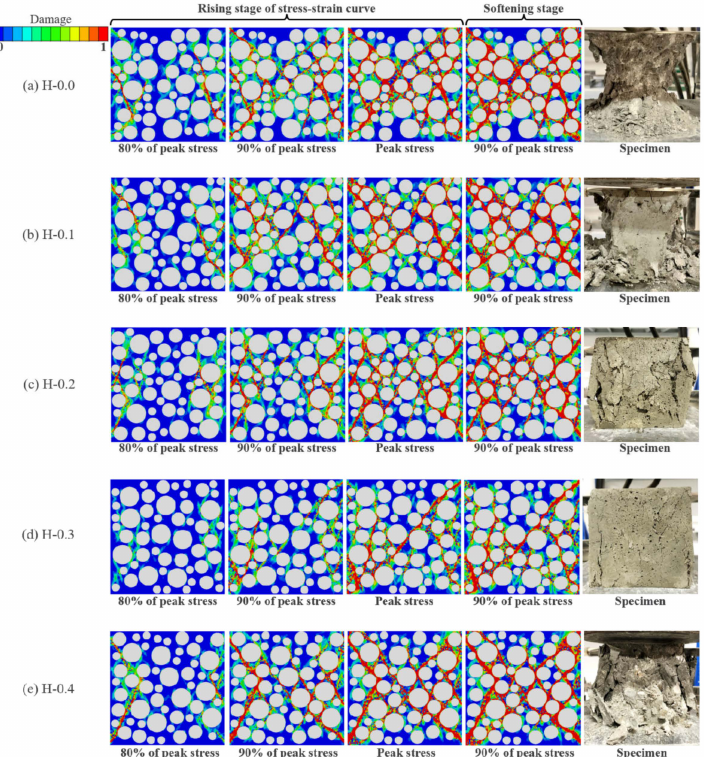
Figure 24. Mesoscale numerical simulation of uniaxial compressive damage evolution of LHPCC with various hybrid fiber contents. ( a ) comparison of the failure model at different loading stages of the concrete without adding fibers; ( b ) comparison of the failure model at different loading stages of the concrete with fiber contents at 0.1%; ( c ) comparison of the failure model at different loading stages of the concrete with fiber contents at 0.2%; ( d ) comparison of the failure model at different loading stages of the concrete with fiber contents at 0.3%; ( e ) comparison of the failure model at different loading stages of the concrete with fiber contents at